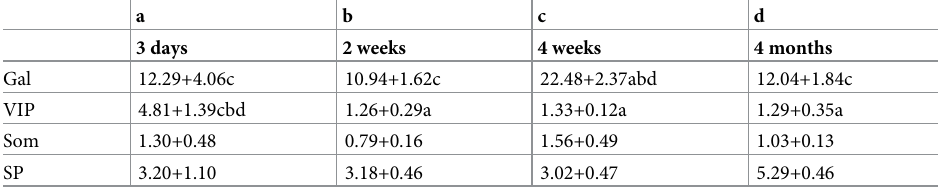
Table 8. Concentrations of the studied neuropeptides in lymph nodes shown as ng/g wet weight.